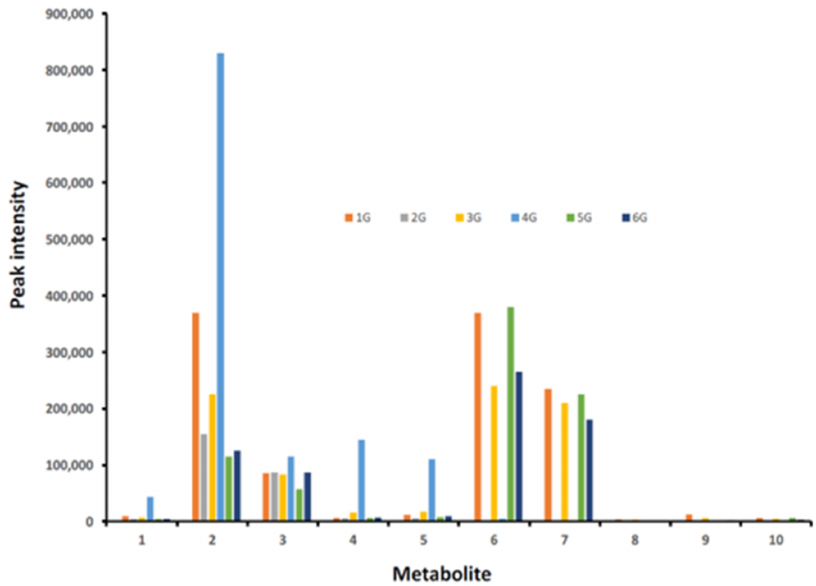
Fig 7. Peak intensities of GE and its metabolites in urines of mice. The nominalmasses of the GE metabolites are: m/z 269 –GE ( 1 ), m/z 349 –GE sulfate ( 2 ), m/z 445—GE β -glucuronide ( 3 ), m/z 525—GE sulfate/ β -glucuronide( 4 and 5 ), m/ z 201–4-ethylphenyl sulfate ( 6 ), m/z 297–4-ethylphenyl β -glucuronide ( 7 ), m/z 165–2-(4-hydroxyphenyl) propionicacid ( 8 ), m/z 245–2-(4-sulfoxyphenyl) propionicacid ( 9 ), m/z 341 2- (4- β -glucuronylphenyl) propionicacid ( 10 ). G denotesthe cages with mice on GE-containing diet. Mice were treated with patient fecal material obtained before (#s 1G, 3G, 5G) and after (#s 2G, 4G and 6G)